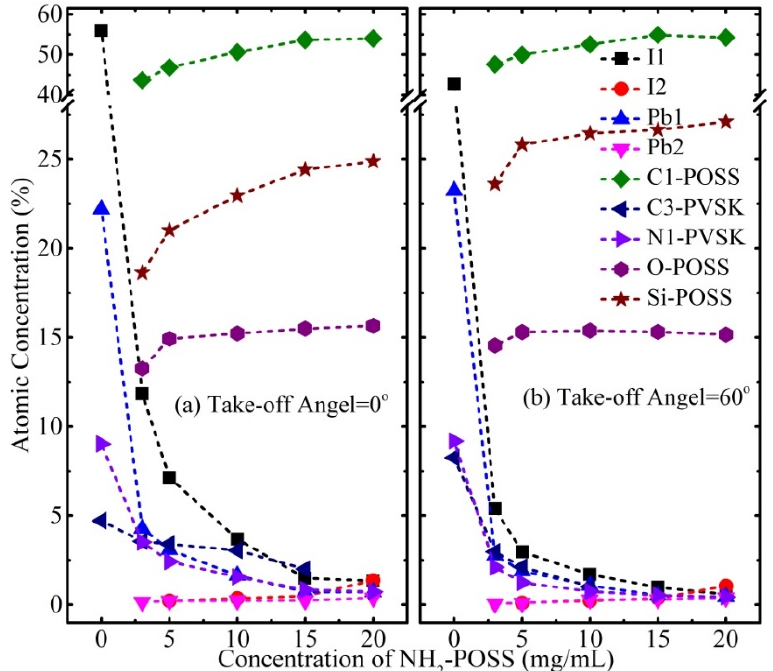
Figure 3. Atomic concentration of all components in the perovskite films as a function of the concentration of NH 2 -POSS. ( a ) The take-off angle is 0°; ( b ) the take-off angle is 60°.